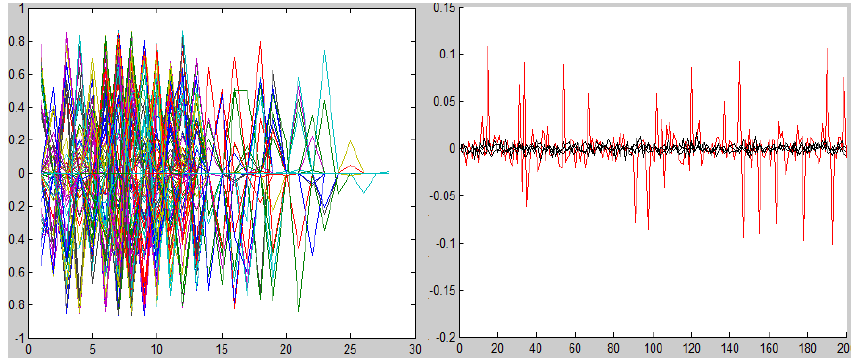
Figure 23. Left: This plot represents 200 d -support global-characteristic sensors, d = 4 . They were obtained as shown in Section 6.1. Right: The spectrum of the target (red) and the PCA of the background (black) after the application of the projection separators. The x-axis represents the wavelengths and the y-axis represents the wavelengths amplitude before (left) and after (right) the application of the